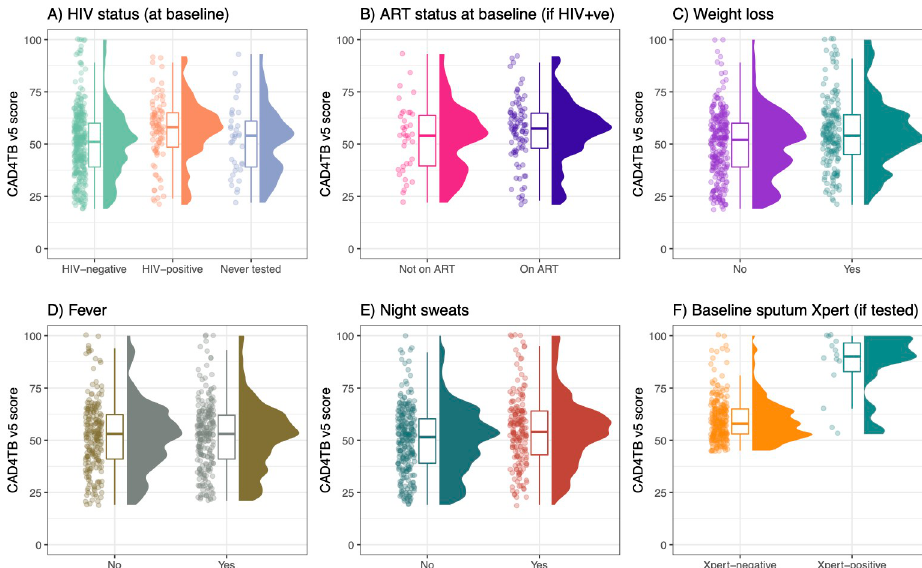
Fig 2. CAD4TBv5 scores by participant characteristics (HIV-TB screening arm only). ART, antiretroviral therapy; TB,